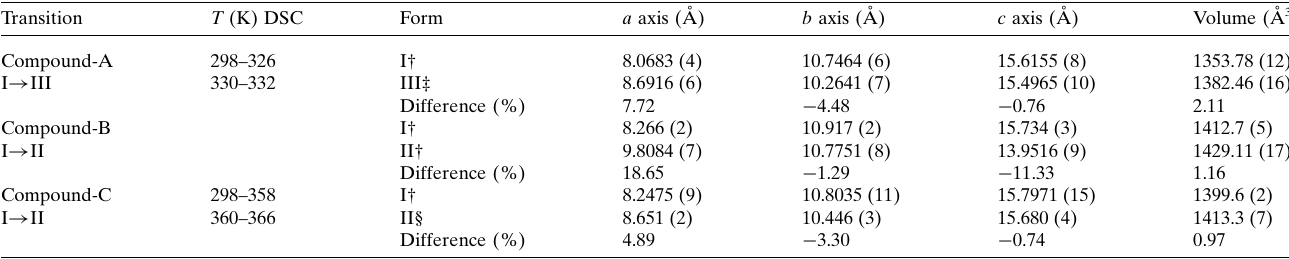
Table 5 Cell parameters and phase transitions of the polymorphs. Transition